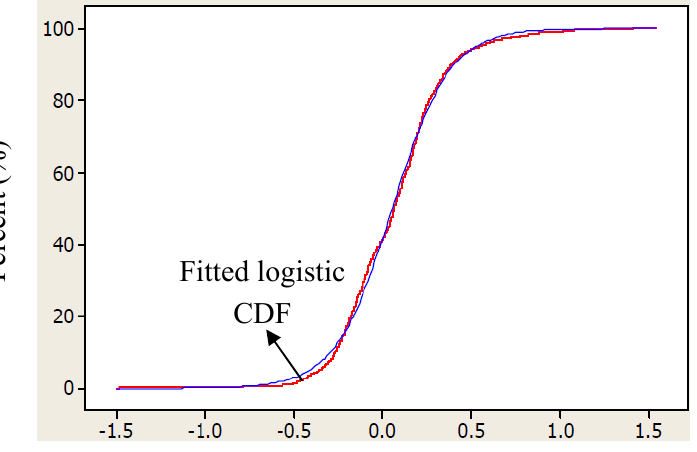
Figure 2. Logistic cumulative distribution function (CDF) fitted to both daytime and